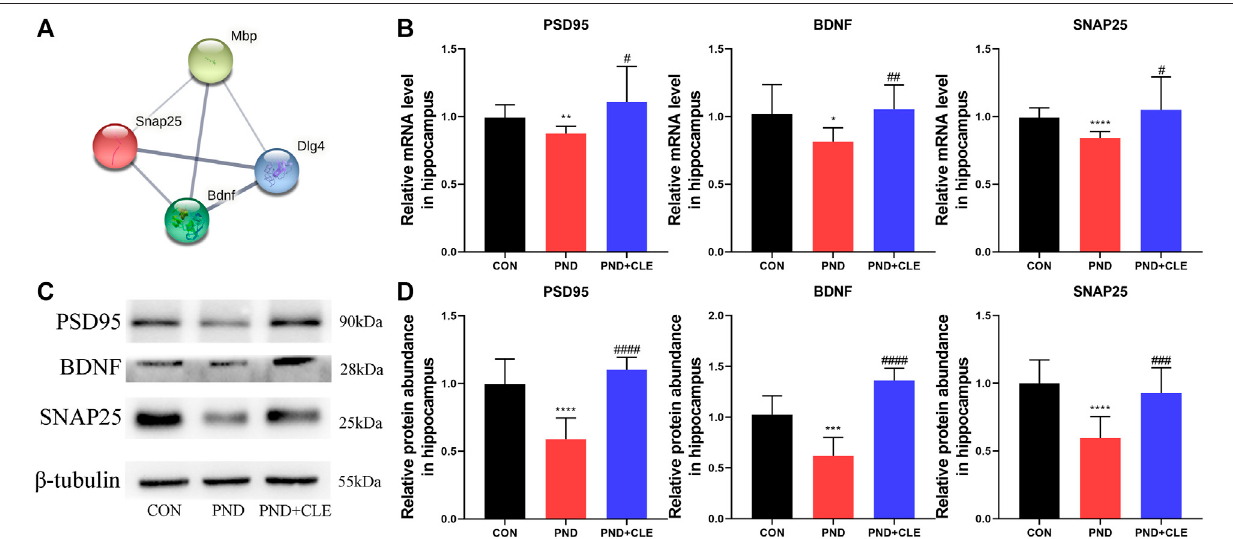
FIGURE 6 | Effects of clemastine on expression levels of synaptic plasticity-related proteins in hippocampus of aged mice after anesthesia and surgery. ( A ) Co- expression relationship of MBP, PSD95 (or DLG4), BDNF and SNAP25 from the STRING database. ( B ) Relative mRNA expressions of PSD95, BDNF and SNAP25, normalized to that of the GAPDH internal control. ( C ) Representative western blot images of synaptic plasticity-related proteins. ( D ) Relative protein expressions of PSD95, BDNF and SNAP25, normalized to that of the β -tubulin internal control. The data are presented as mean ± S.D. ( n (cid:1) 10 mice per group). * p < 0.05 compared with the CON group. ** p < 0.01 compared with the CON group. *** p < 0.005 compared with the CON group. **** p < 0.001 compared with the CON group. # p < 0.05 compared with the PND group. ## p < 0.01 compared with the PND group. ### p < 0.005 compared with the PND group. #### p < 0.001 compared with the PND